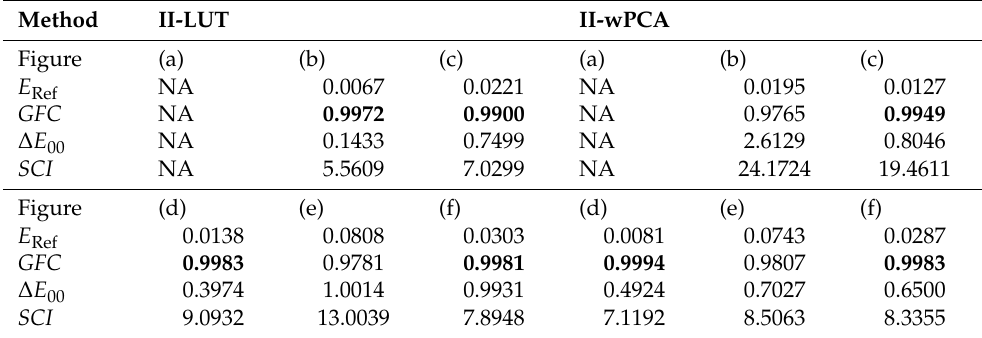
Table 10. Assessment metric values for the cases in Figure 21b–f. GFC values greater than 0.99 are shown in bold.